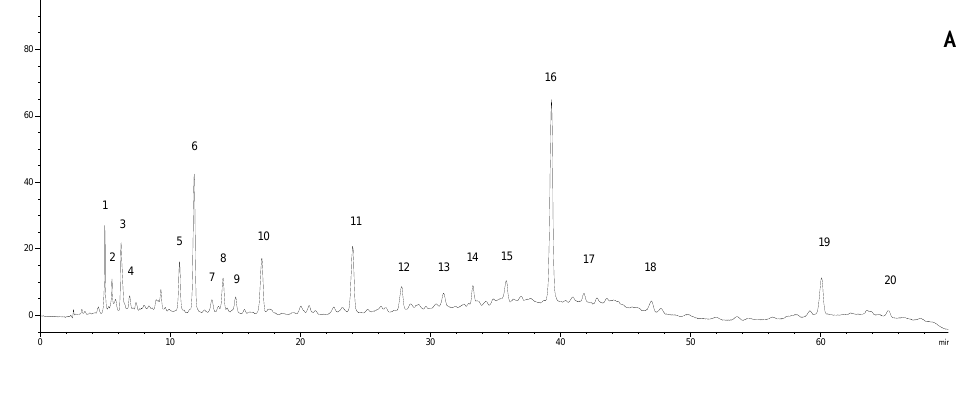
Figure 5. HPLC chromatograms of PV extracts of different Prunella samples from different regions.